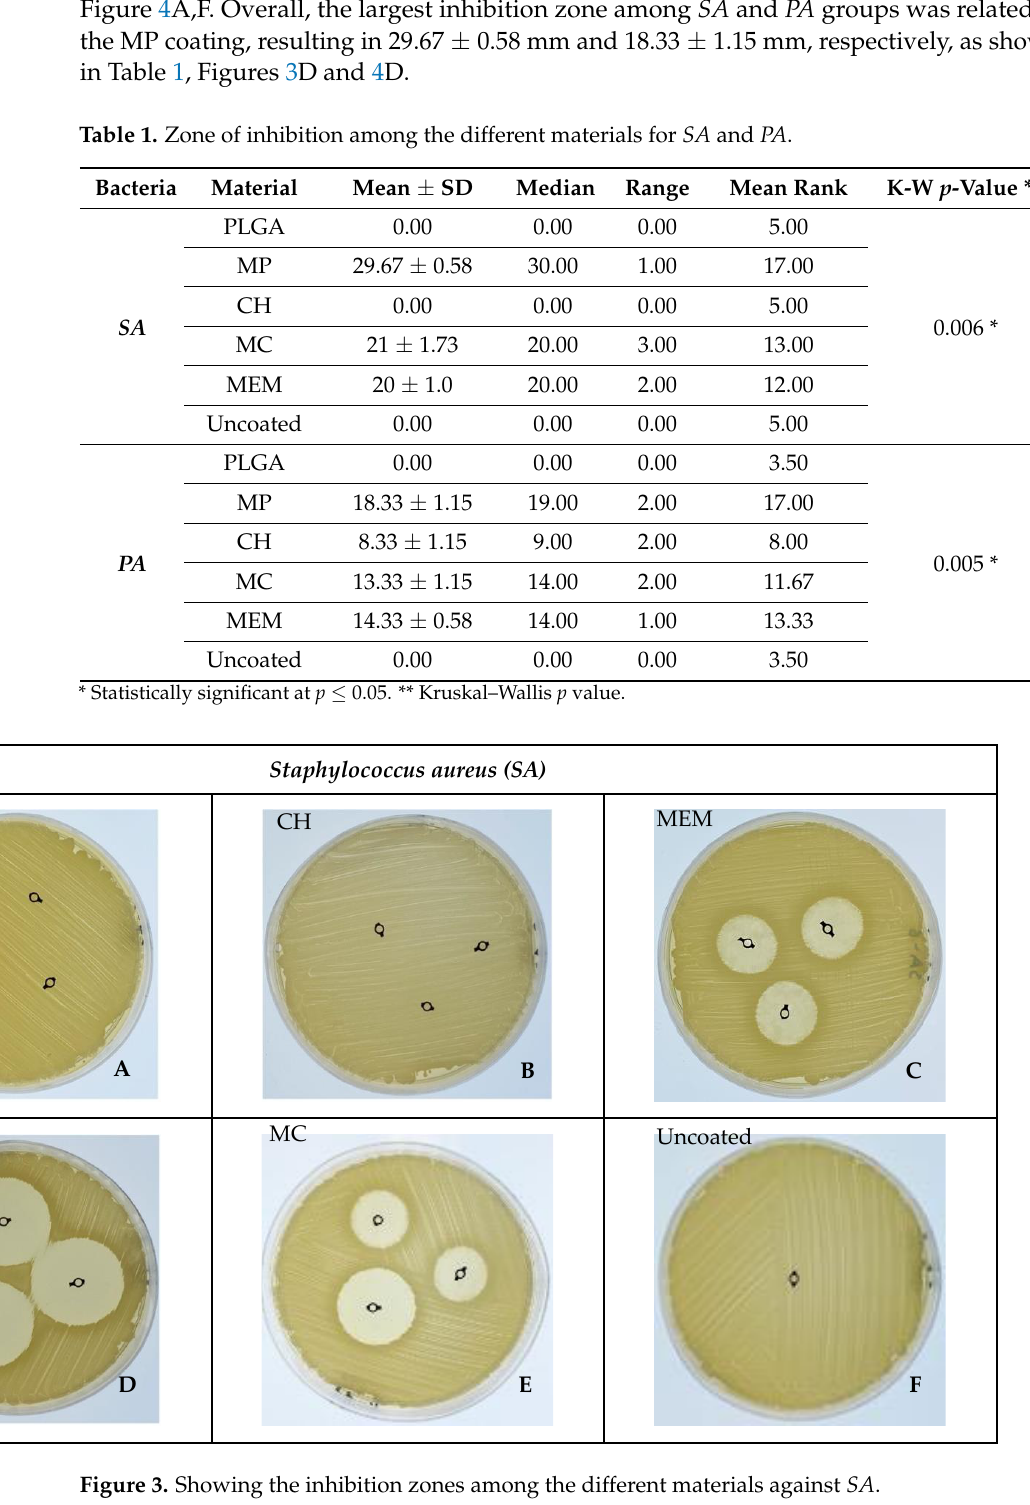
Figure 3. Showing the inhibition zones among the different materials against SA